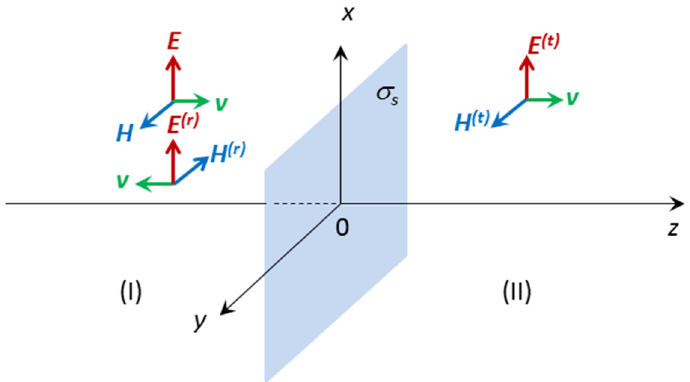
Figure 3. The model of fabric covered with conductive paste. On the left side of the sample there are incident and reflected waves. The later is denoted by superscript (r) . On the right side the only are incident and reflected waves. The later is denoted by superscript ( r ). On the right side the only transmitted wave appears. Its amplitudes are denoted by superscript (t). transmitted wave appears. Its amplitudes are denoted by superscript ( t